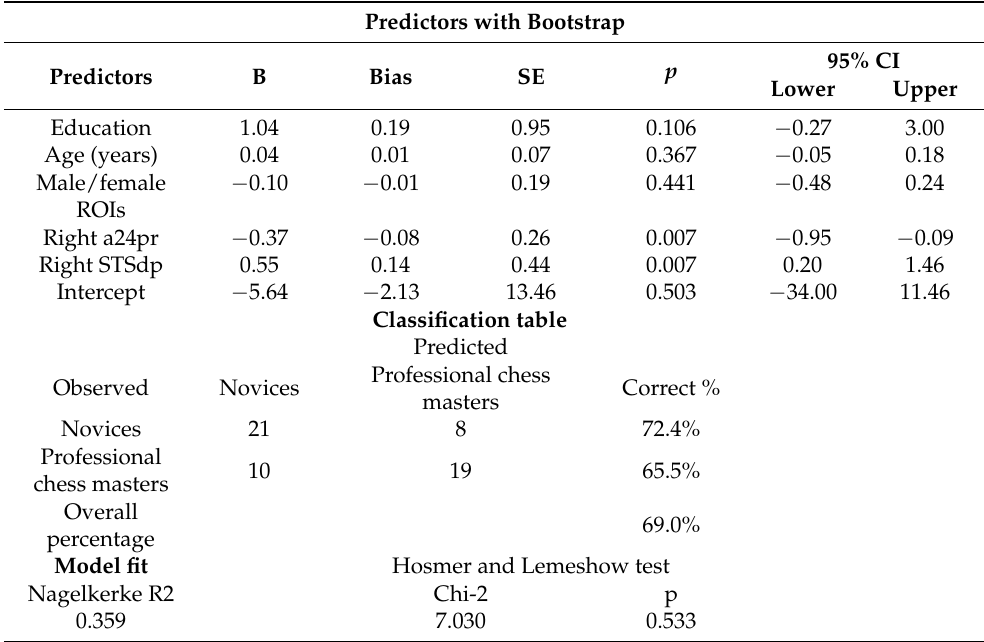
Table 3. Logistic regression model predicting chess expertise based on the gyrification index of the specific regions of interest (ROI), after controlling for age, education, and sex. Predictors with Bootstrap Predictors B